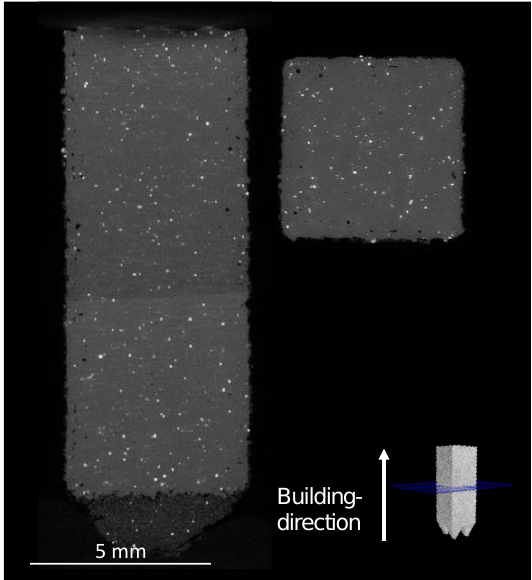
Figure 4. CT scan of a 5 × 5 × 16 mm 3 as-built LPBF specimen manufactured with the powder mix- ture.